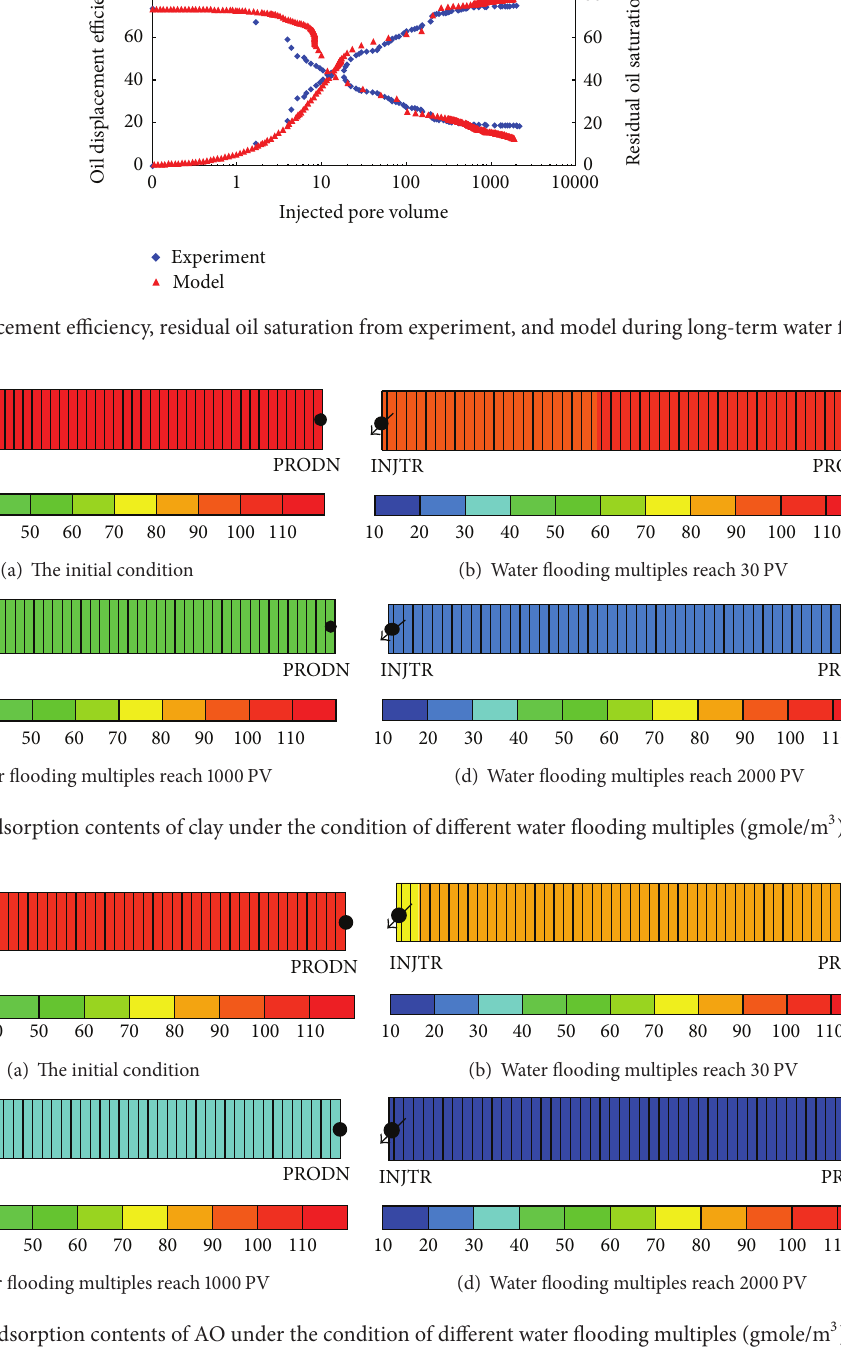
Figure 10: Adsorption contents of AO under the condition of different water flooding multiples (gmole/m 3